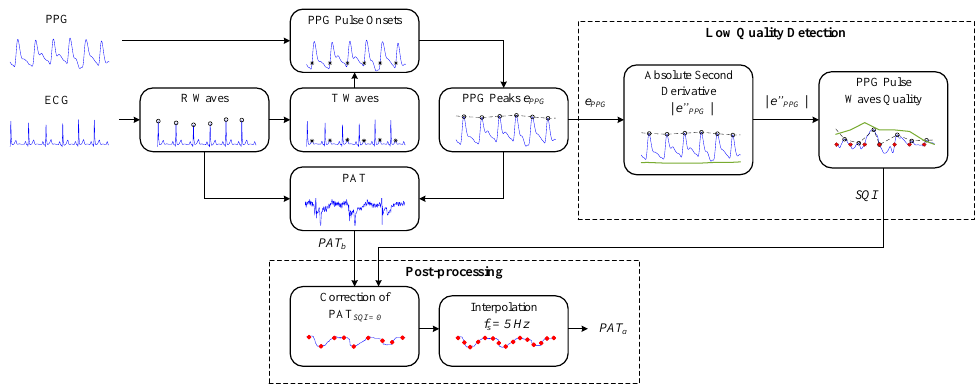
Figure 2. The block diagram of the PPG signal-quality assessment algorithm for robust PAT estimation. Algorithm 1 ECG-Guided PPG Signal-Quality